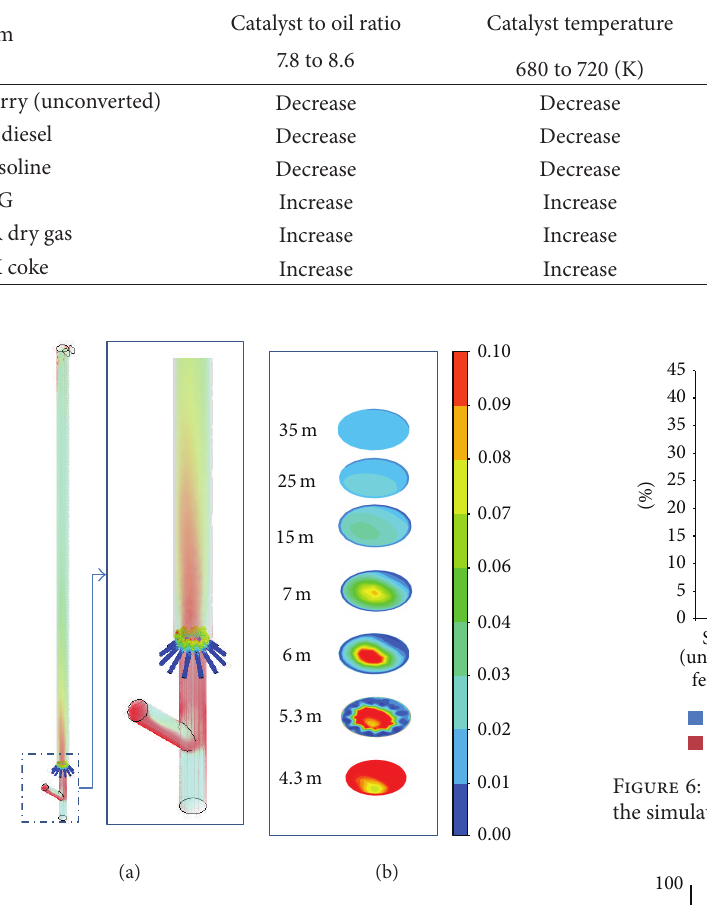
Figure4:Volumerenderingandcontourprofilesforaxialandradial planes of catalyst volume fractions.